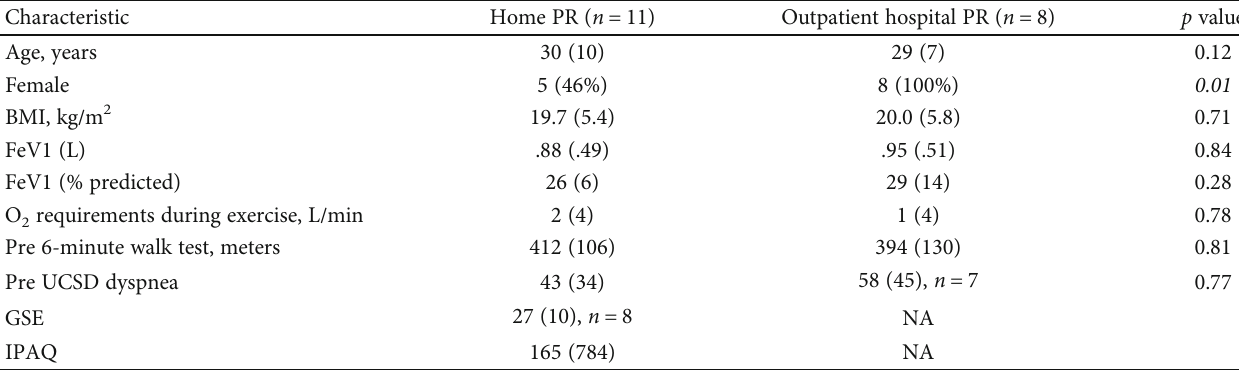
Table 1: Patient demographics and baseline clinical characteristics.